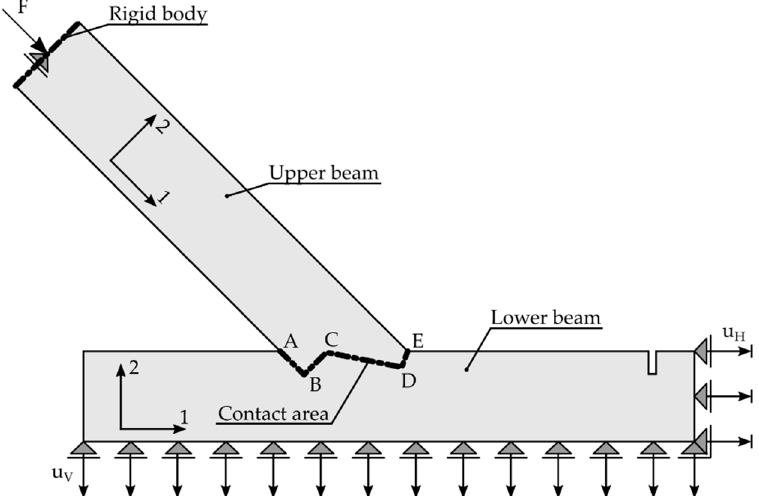
Figure 18. Geometrical data of the FEM model for the double-step joint. Axis 1 represents the ori- entation parallel to the grain. orientation parallel to the grain.